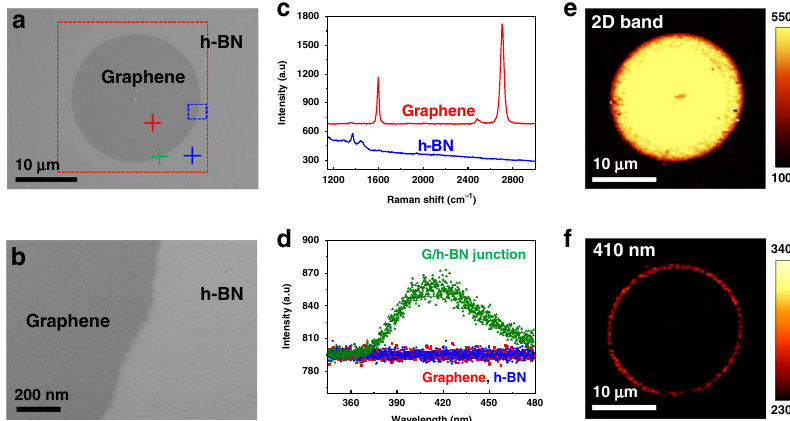
Fig. 1 Characterization and PL analysis of graphene/h-BN in-plane heterostructures. a , b SEM images of in-plane graphene/h-BN heterostructures fabricated by conversion reaction of h-BN on a Pt (111) single crystal. The location of the magni fi ed SEM image, ( b ), is marked by the blue rectangle in a . c Raman spectra of graphene (red) and h-BN (blue) regions on a SiO 2 /Si substrate using a 532-nm laser. d PL spectra of graphene (red), h-BN (blue) regions, and interface (green) using a 266-nm laser. e , f Raman and PL mapping images of the 2D band (2630 – 2730cm − 1 ) and 410 nm wavelength, respectively, for the area inside the red square in a .